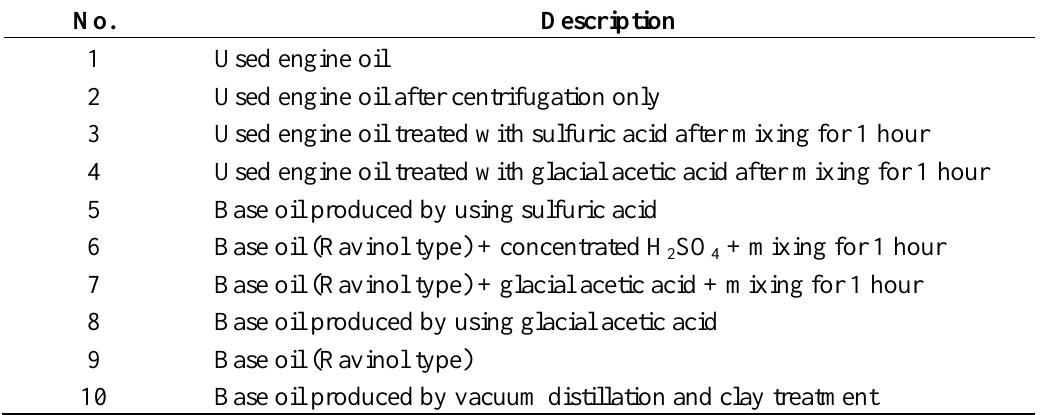
Table 7. Description of the engine oil samples in Figure